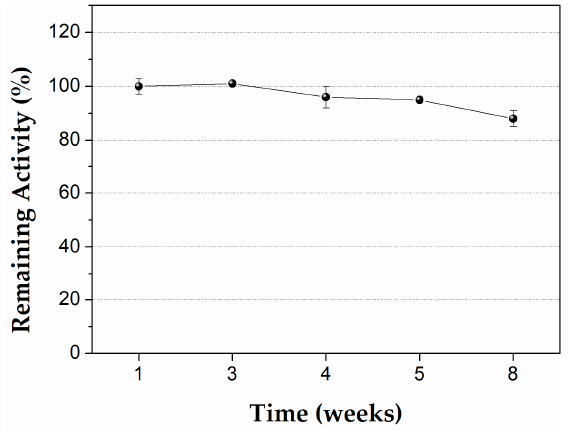
Figure 6. Storage stability of immobilized CALB on PLA wells, at 4 °C. One hundred percent is defined as the initial activity (activity before the storage). Reaction conditions: 0.25 mM pNPB in 50 mM phosphate buffer pH 7.5, 40 °C, reaction time 5 min.